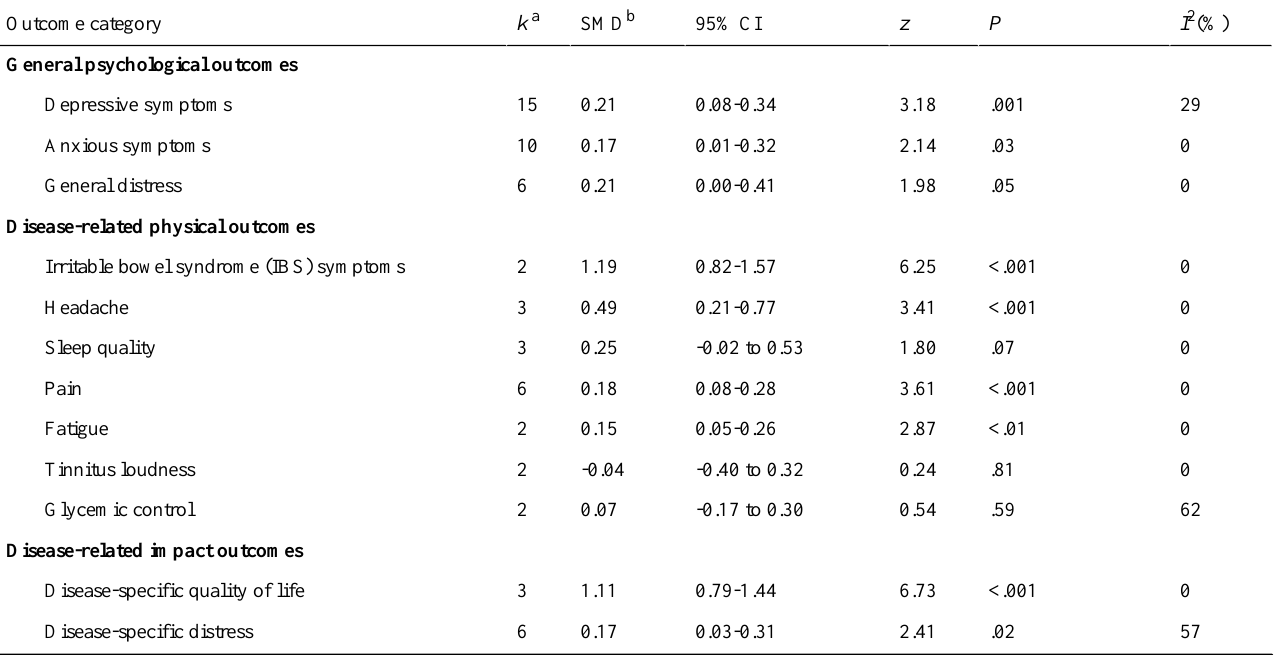
Table 1. Pooled SMDs for ICBT versus passive control conditions.